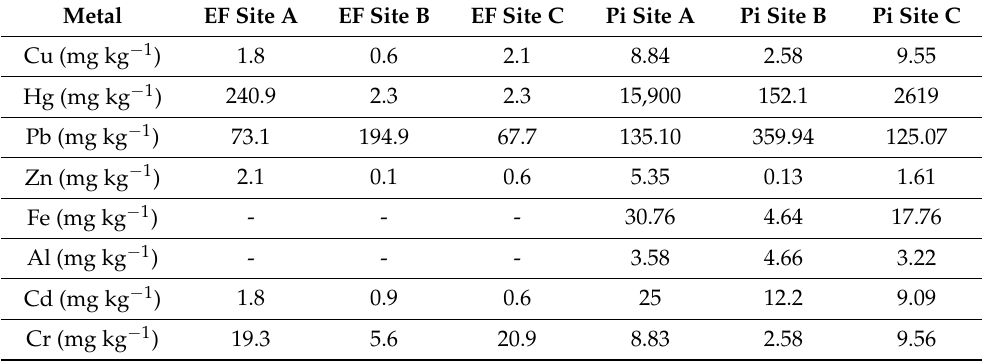
Table 4. Variation in single pollutant (Pi) concentration in the different